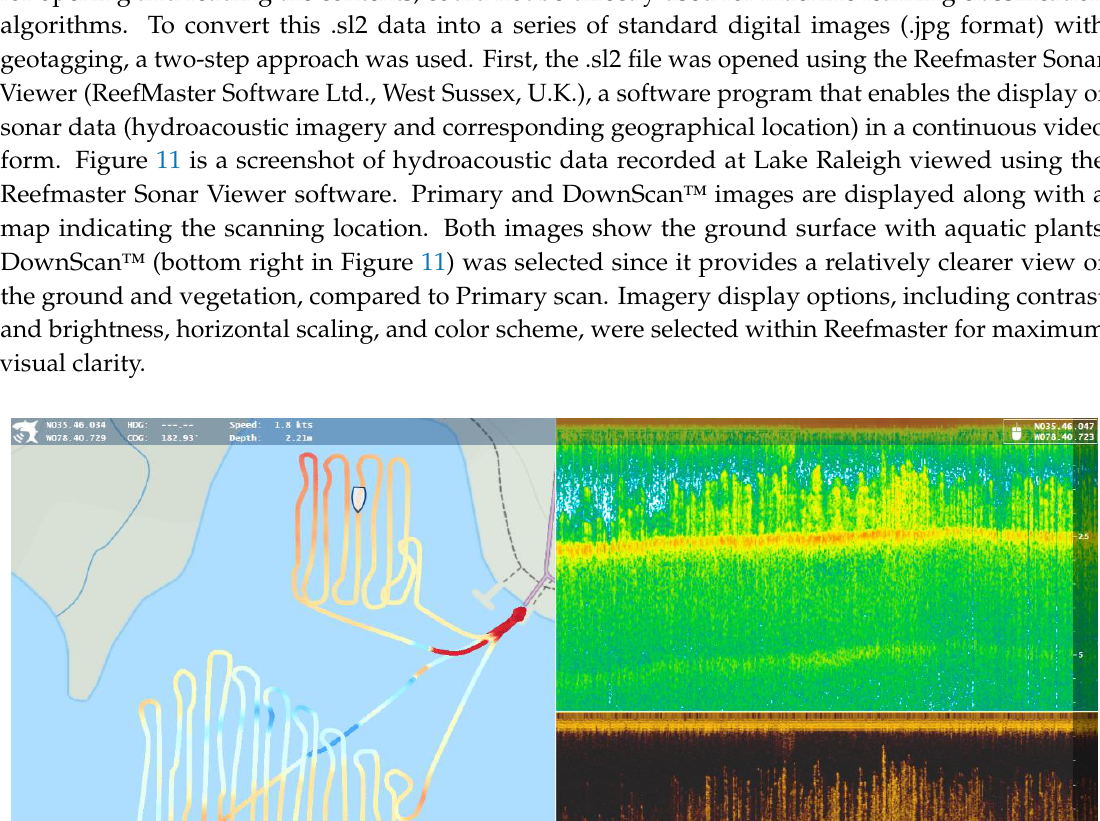
Figure 12. Geo- tagged DownScan™ image with GPS coordinates in the top left corner.